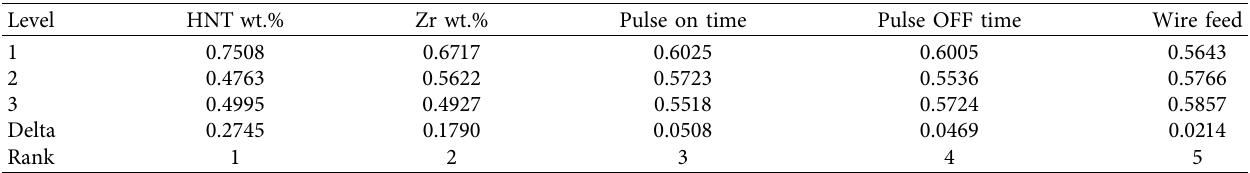
Table 7: A typical response for GRG.